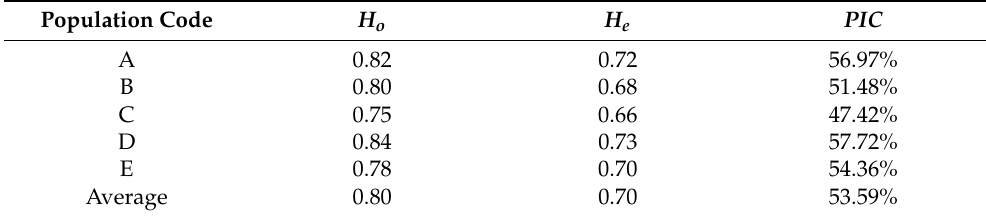
Table 5. Gene diversity in the five populations of Ootheca mutabilis . Alphabet letters represent populations; (A) Northern moist farmlands, (B) Western mid-altitude farmlands, (C) Central wooden savannah, (D) Southern and Eastern Lake Kyoga basin and € North-western farmlands. Observed heterozygosity ( H o ) ; expected heterozygosity ( H e ), and polymorphic information content ( PIC ) are shown.